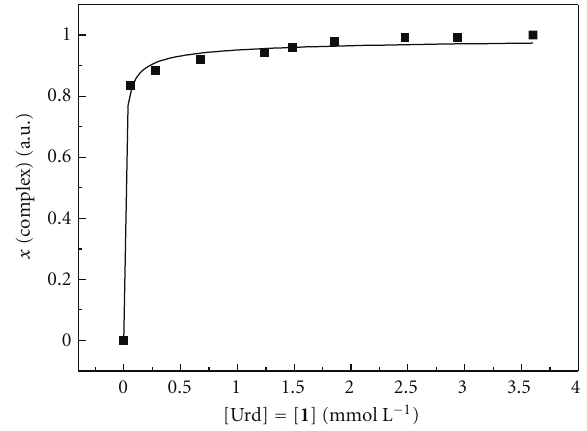
Figure 2: Mole fraction of uridine in complex as a function of the concentration of uridine and 1 ; pH = 7.3.